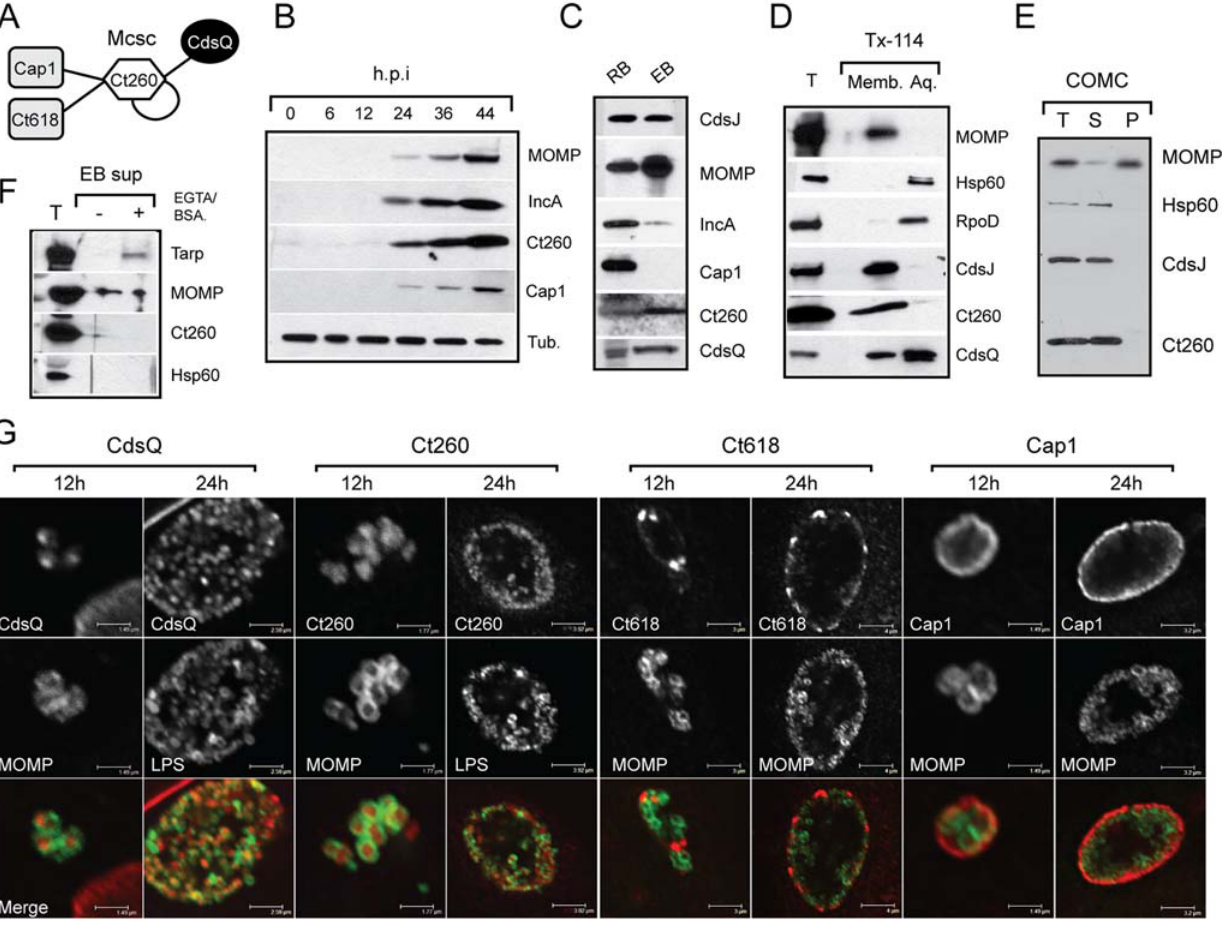
Figure 2. Components of a Chlamydia injectisome protein-protein interaction hub localize to distinct subcellular sites. ( A ). Network of predicted Ct260 (Mcsc) protein-protein interactions . Interactions were defined by Y2H analysis as described in Fig. 1D. ( B–C ). Ct260 and CdsQ are expressed throughout infection . ( B ). HeLa cells were infected with C. trachomatis and total protein samples collected at various times post-infection. Ct260, the bacterial major outer membrane protein (MOMP), and the inclusion membrane proteins IncA and Cap1 were detected with specific antibodies. Tubulin levels were serve as protein loading controls. ( C ). Reticulate bodies (RBs) and EBs were purified from infected cells by density gradient and total proteins were analyzed by immunoblot analysis with antibodies against the indicated chlamydial proteins. ( D–E ). Ct260 and CdsQ partition with membranes and hydrophobic proteins . ( D ). EBs were extracted with Triton-X114 to separate membrane from non-membrane associated proteins. Ct260 partitioned with the detergent fraction along with integral membrane proteins CdsJ and MOMP, but not the cytoplasmic proteins Hsp60 and RpoD. CdsQ partitioned in both membrane and aqueous fractions. ( E ). Ct260 is sensitive to Sarcosyl extraction, a detergent that solubilizes all membrane proteins except COMC, suggesting a lack of association with chlamydia outer membrane complexes (COMC) ( F–G ). Ct260 is not a target of T3S . ( F ). Secretion of T3S was induced by treatment of EBs with 0.5% BSA and 10mM EGTA. Tarp, but not Ct260, was detected in the extracellular media. ( G ). CdsQ and Ct260 localize to bacteria while Cap1 and Ct618 localize to the inclusion membrane. Ct260 and CdsQ (red) were observed exclusively in association with MOMP or LPS-positive (green) bacteria at early (12 h) and late (24 h) post-infection. Ct618 and Cap1 (red) localize to the extra-bacterial structures, including inclusion membranes. Scale bar range: 1.5 m m (12 h) to 4 m m (24 h). Abbreviations: (h.p.i.) hours post infection, (T) total lysates from purified EBs, (Memb.) and (Aq.) represent the detergent and aqueous phase of Triton-X114 extraction, (S) and (P) denote the soluble and insoluble protein fractions extracted with Sarcosyl respectively. Mcsc: Functional nomenclature for Ct260 (See Fig.